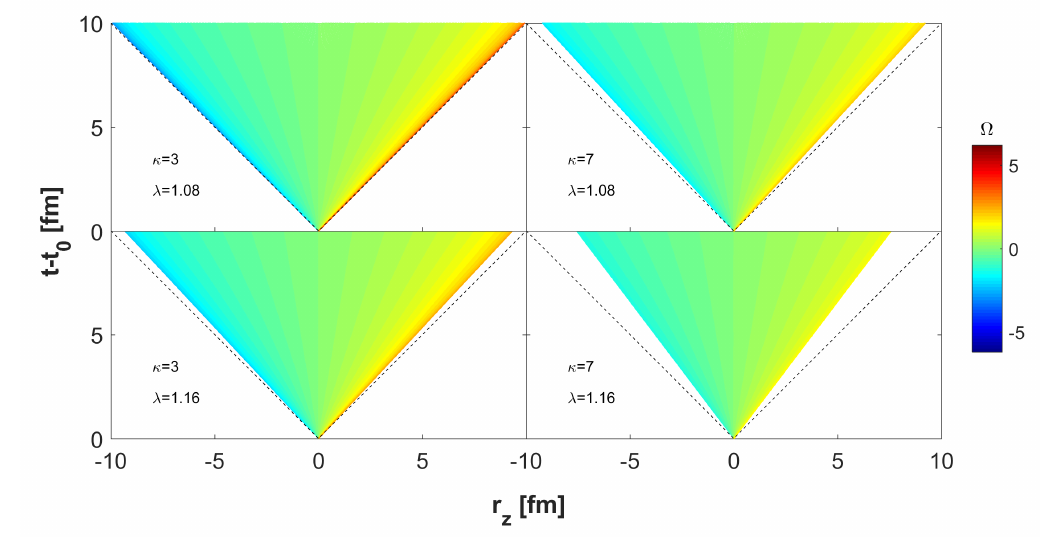
Figure 3. Fluid rapidity Ω maps in the forward light cone from our new, longitudinally finite solutions are shown for for κ = ε / p = 3 (left column) and for κ = 7 (right column) evaluated for the acceleration parameters λ = 1.08 in the top row and for λ = 1.16 in the bottom row.